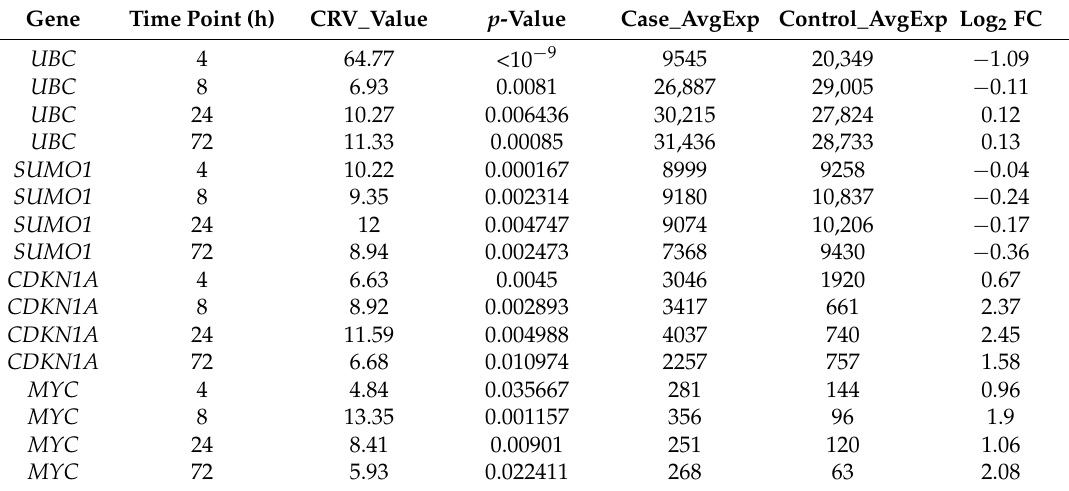
Figure 1. The constructed traumatic brain injury (TBI) differential protein–protein interaction networks (PPINs; DPPINs) for four time points post-TBI. These figures include edge and node information. The DPPIN is the difference between the TBI PPIN (TPPIN) and non-TBI PPIN (NPPIN). The size of nodes depends on the TBI relevance value (TRV). The proteins with the highest TRVs are defined as the network markers. These figures were created using Cytoscape. ( a ) 4 h; ( b ) 8 h; ( c ) 24 h; ( d ) 72 h. Blue edge means the difference in interaction activity ≤ mean − STD; Red edge means the difference in the interaction activity ≥ mean + STD; Yellow node means the protein with significant CRV. Table 2. The four significant proteins of core network biomarkers (intersections) for the four post-TBI. This table was generated by the Matlab program developed by our team according to the algorithms described in Section 3.3 and Supplementary Materials.